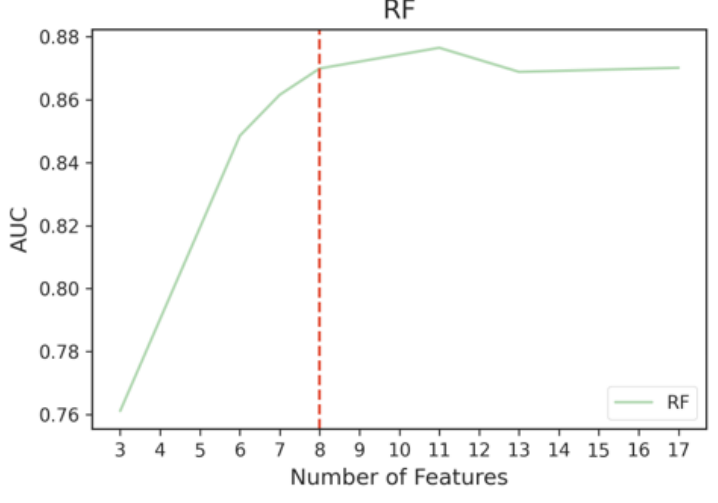
Figure 9. Cutoff point for RF where performance tapers off when adding more ENET features.